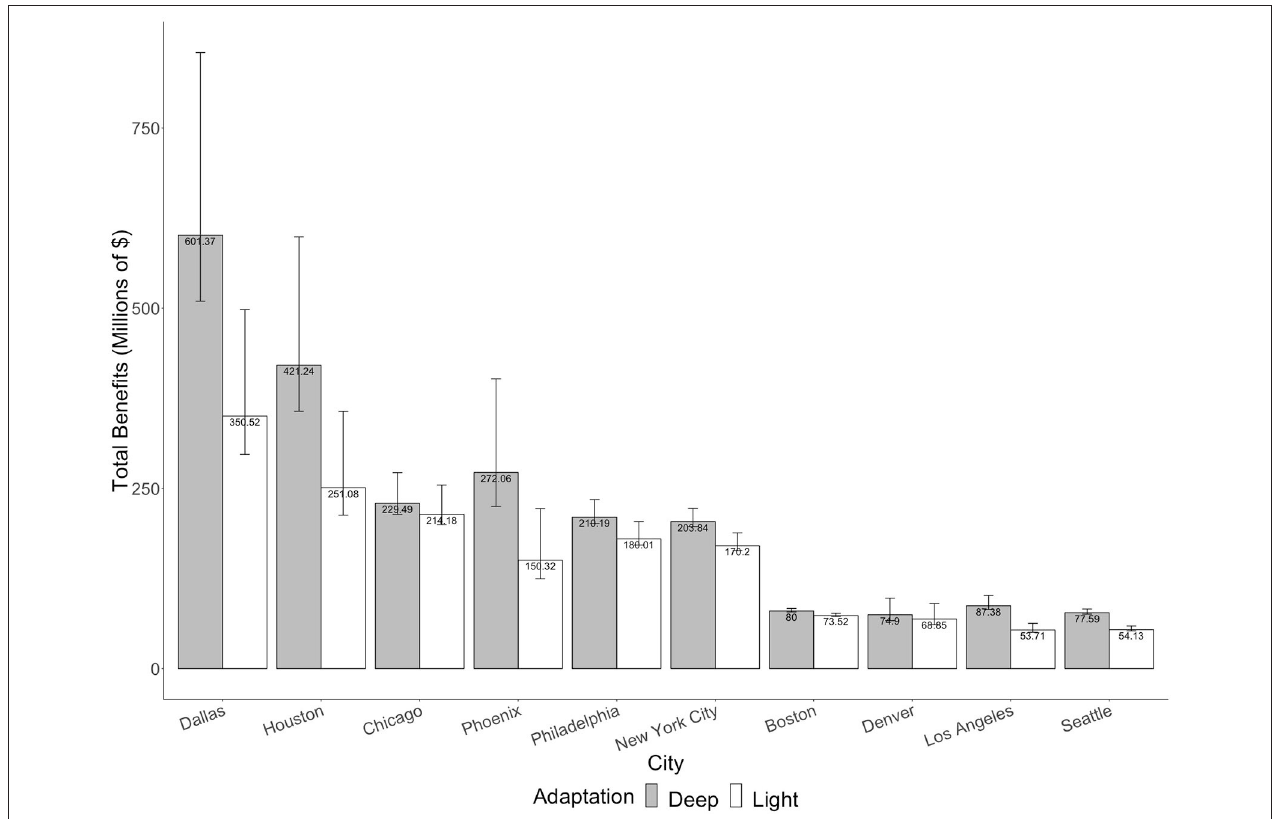
FIGURE 4 | Total estimated benefits (climate, health, and utility) (million 2016 USD) from light (white) or deep (gray) heat adaptation retrofits applied to detached single-family residential buildings built from 1990 to 2010. Error bars indicate low- and high-range estimates.